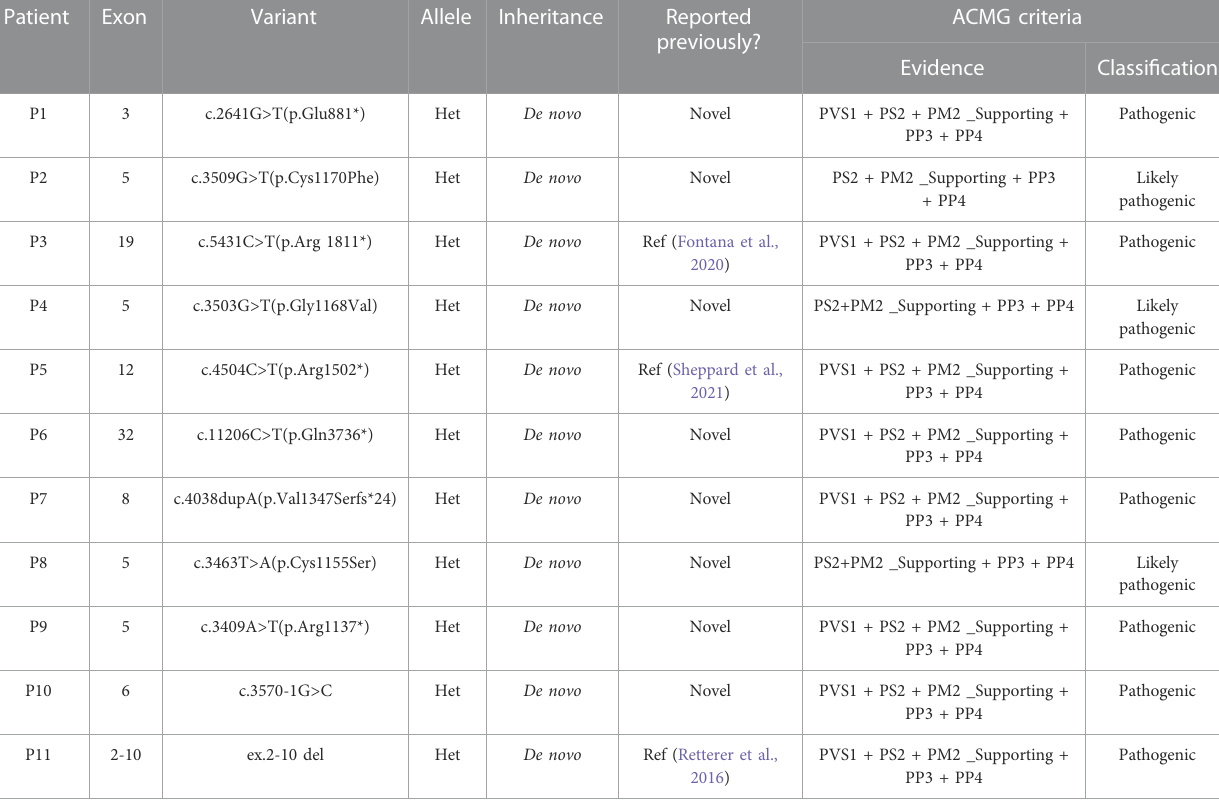
TABLE 1 Deleterious KMT2A variants identi fi ed in 11 Chinese WSS patients.